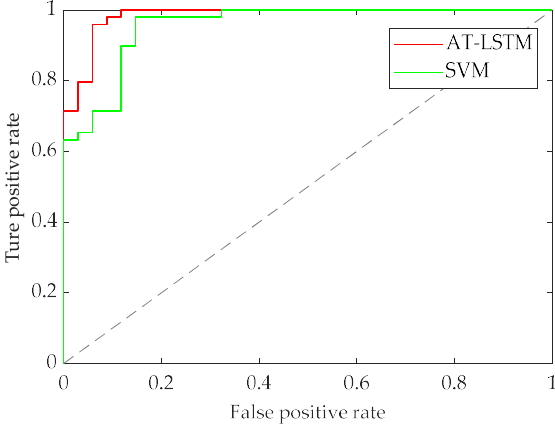
Figure 11. ROC curve of model identification 0 s in advance.